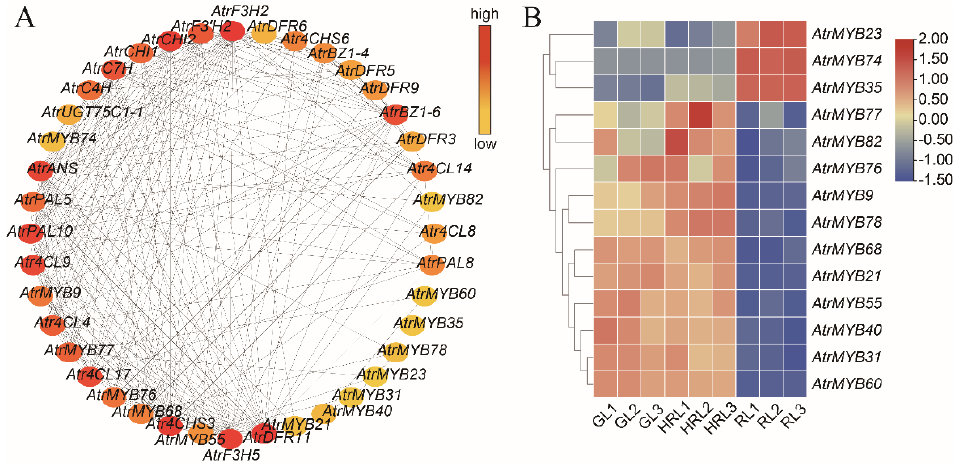
Figure 10. The top 40 nodes of the PPI network between differentially expressed AtrMYBs and anthocyanin synthesis structural genes ( A ) and the expression level of AtrMYBs in green (GL), orange (HRL), and red (RL) leaves ( B ).